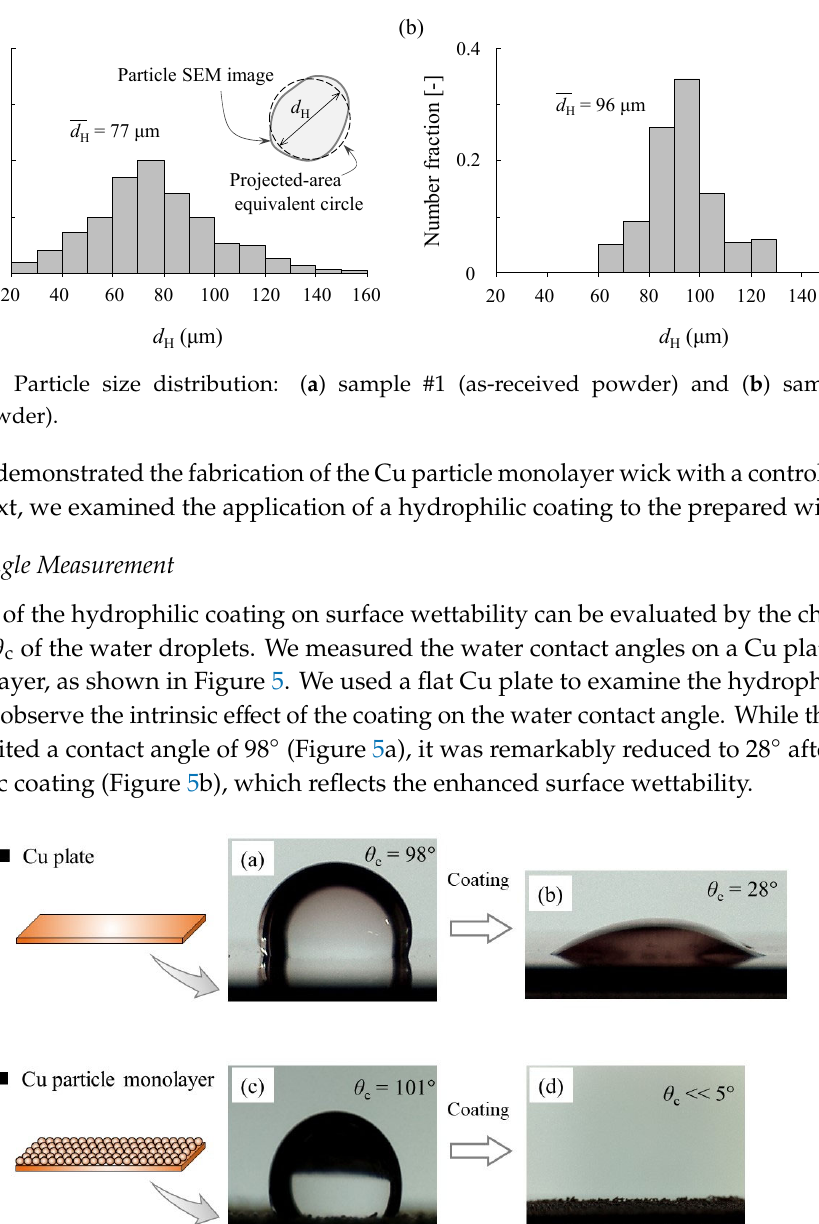
Figure 6. SEM images of Cu particles: ( a ) uncoated and ( b ) coated.